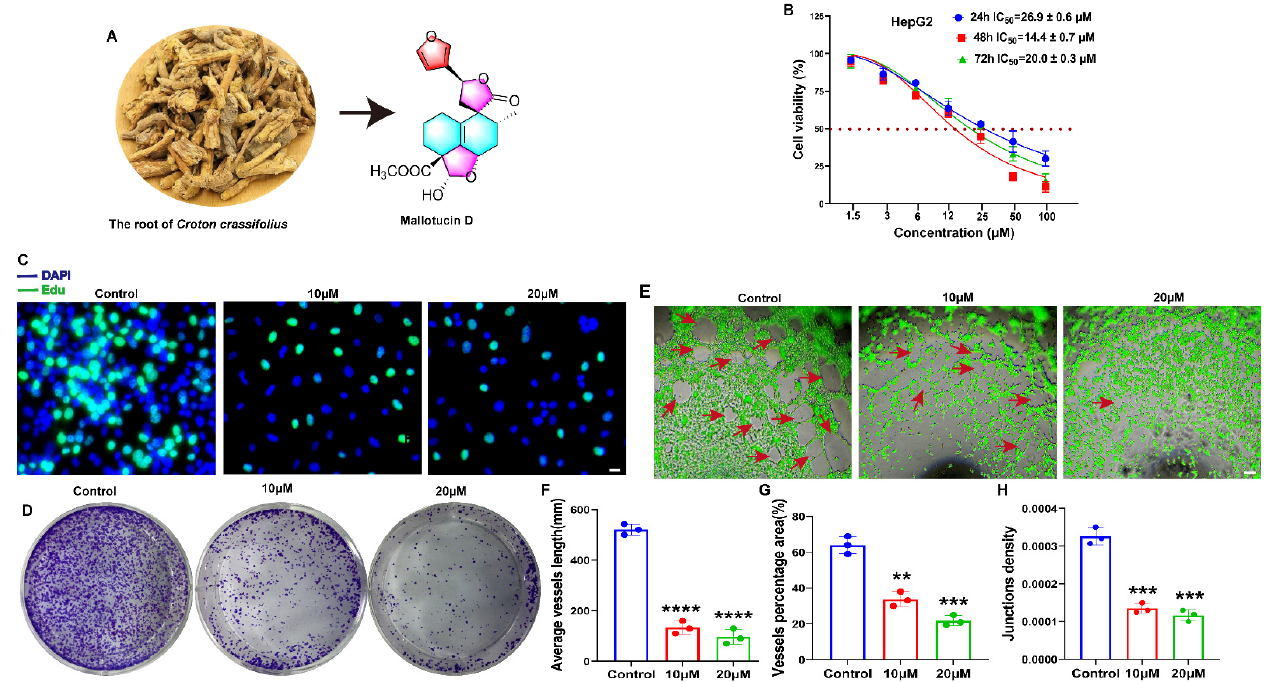
Figure 1. MLD suppressed the proliferation of HepG2 cells and angiogenesis of HUVECs. ( A ) Struc- ture of MLD. ( B ) Cell viability of HepG2 cells after MLD treatment for 24 h, 48 h, and 72 h as determined by MTT assay. ( C ) The inhibitory effect on DNA synthesis in HepG2 cells was detected by Edu staining after treatment with MLD for 24 h. Scale bar: 100 µ m. ( D ) The inhibitory effect of MLD on HepG2 cell colony formation. ( E ) The ability of HUVEC angiogenesis was inhibited in MLD-treated cells. Scale bar: 150 µ m. Arrow: the angiogenesis-like structure. The statistics of tube-like structure length ( F ), vessel area ( G ), and junction density (H) . The results are representative of three independent experiments and are expressed as the mean ± SD. ** p < 0.01, *** p < 0.001, and **** p < 0.0001 compared with the control